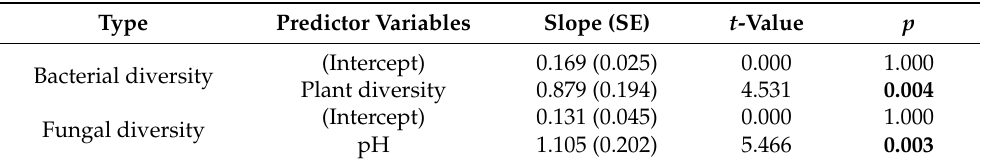
Table 4. Best AIC-selected linear regression model explaining the microbial alpha-diversity of the study areas (n =